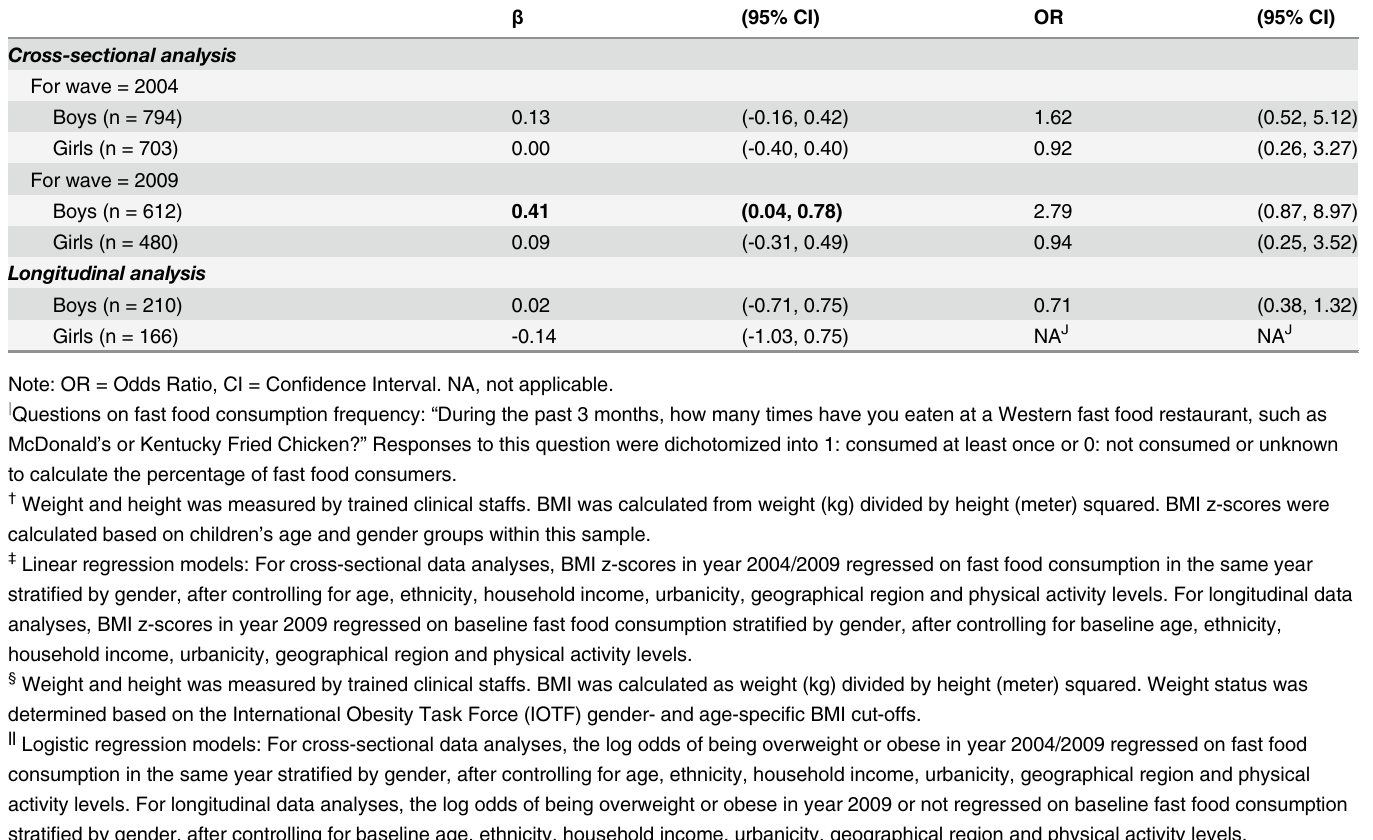
Table 4. Linear and logistic regression analysis for cross-sectional and longitudinal associations between Chinese children ’ s Western fast food consumption and their BMI z-scores and weight status: China Health and Nutrition Survey 2004 – 2009. Consumed fast food | vs. not